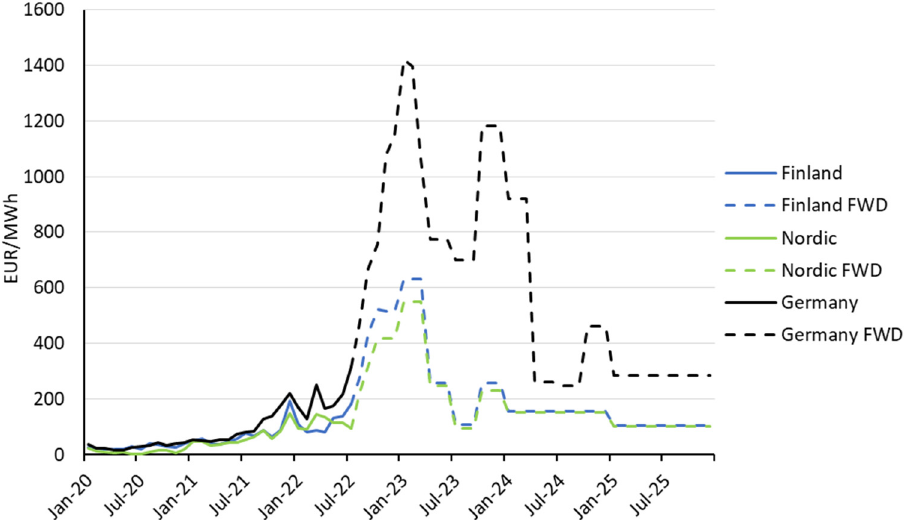
Figure 9. Historical monthly day-ahead prices in Finland, Nordics, and Germany, and forward curves (FWD) from 26 August 2022.